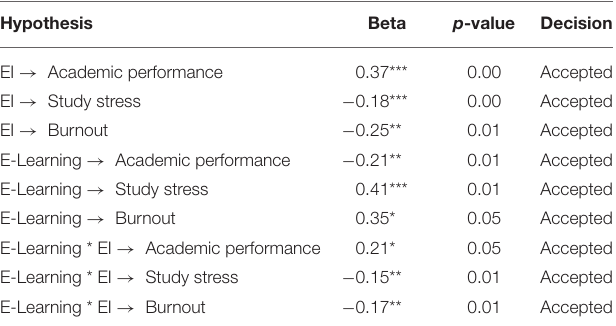
TABLE 3 | Statistical analysis